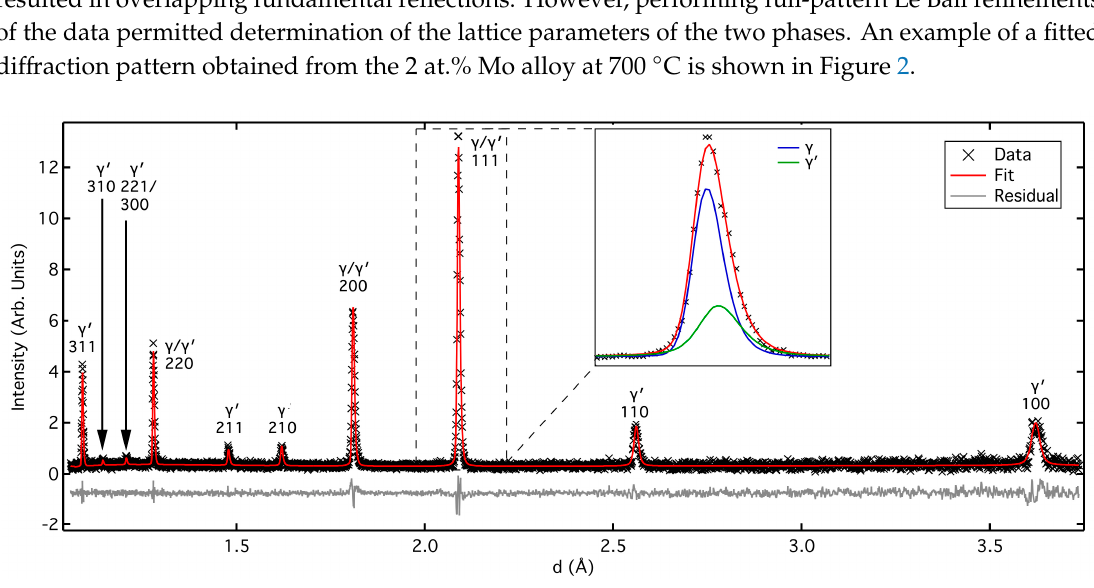
Figure 2. Diffraction pattern of the 2 at.% Mo alloy obtained at 700 °C using time of flight neutron diffraction, with full pattern fit obtained using GSAS, and the associated residual. Inset showing the (111) peak with the fitted contributions from the two phases.